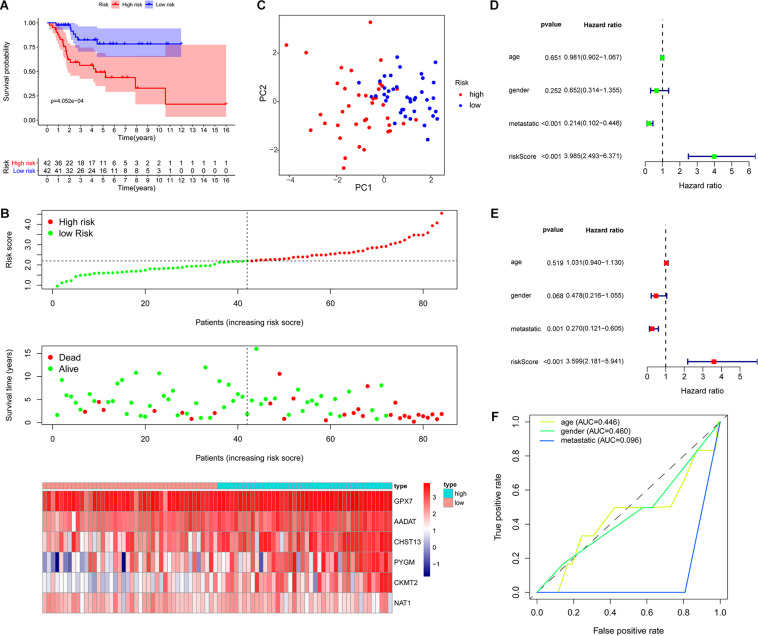
Evaluation of the metabolic gene signature. (A) Kaplan–Meier curves of patients in the low-risk and high-risk groups based on the six metabolic genes signature. (B) Risk score distribution and survival status of OS patients based on the six metabolic genes signature and heat map of the 6 metabolic genes signature expression pattern. (C) PCA based on the confirmed six metabolic genes signature. (D) Univariate Cox regression analysis showing that the metastatic and metabolic genes signature risk scores are significantly associated with overall survival. (E) Multivariate Cox regression analysis showing that the metabolic genes signature risk score is an independent prognostic indicator for overall survival of OS patients. (F) ROC curve analysis with the prognostic accuracy of age, gender, and metastatis.